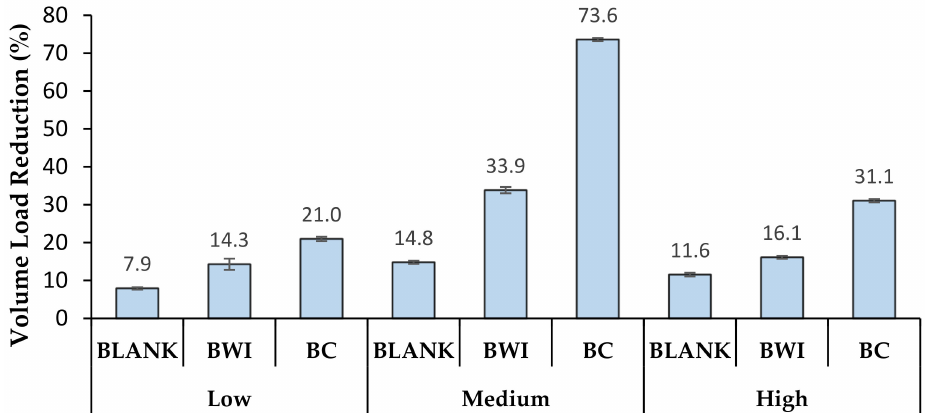
Figure 8. Volume reduction for different levels of deicing salt inflow concentration (blank: no plants; BWI: Blue Wild Indigo; BC: Broadleaf Cattail).